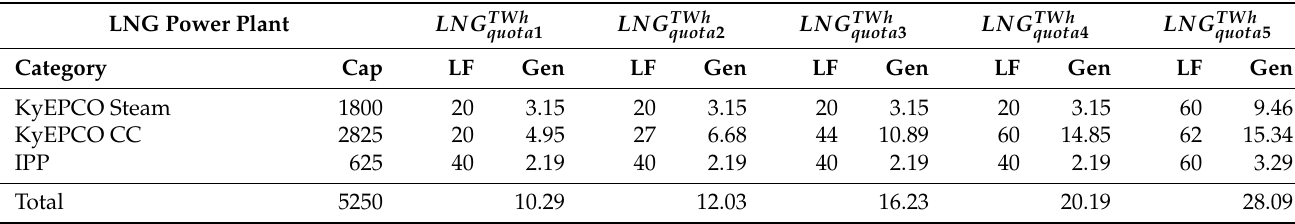
Table 6. LNG quota